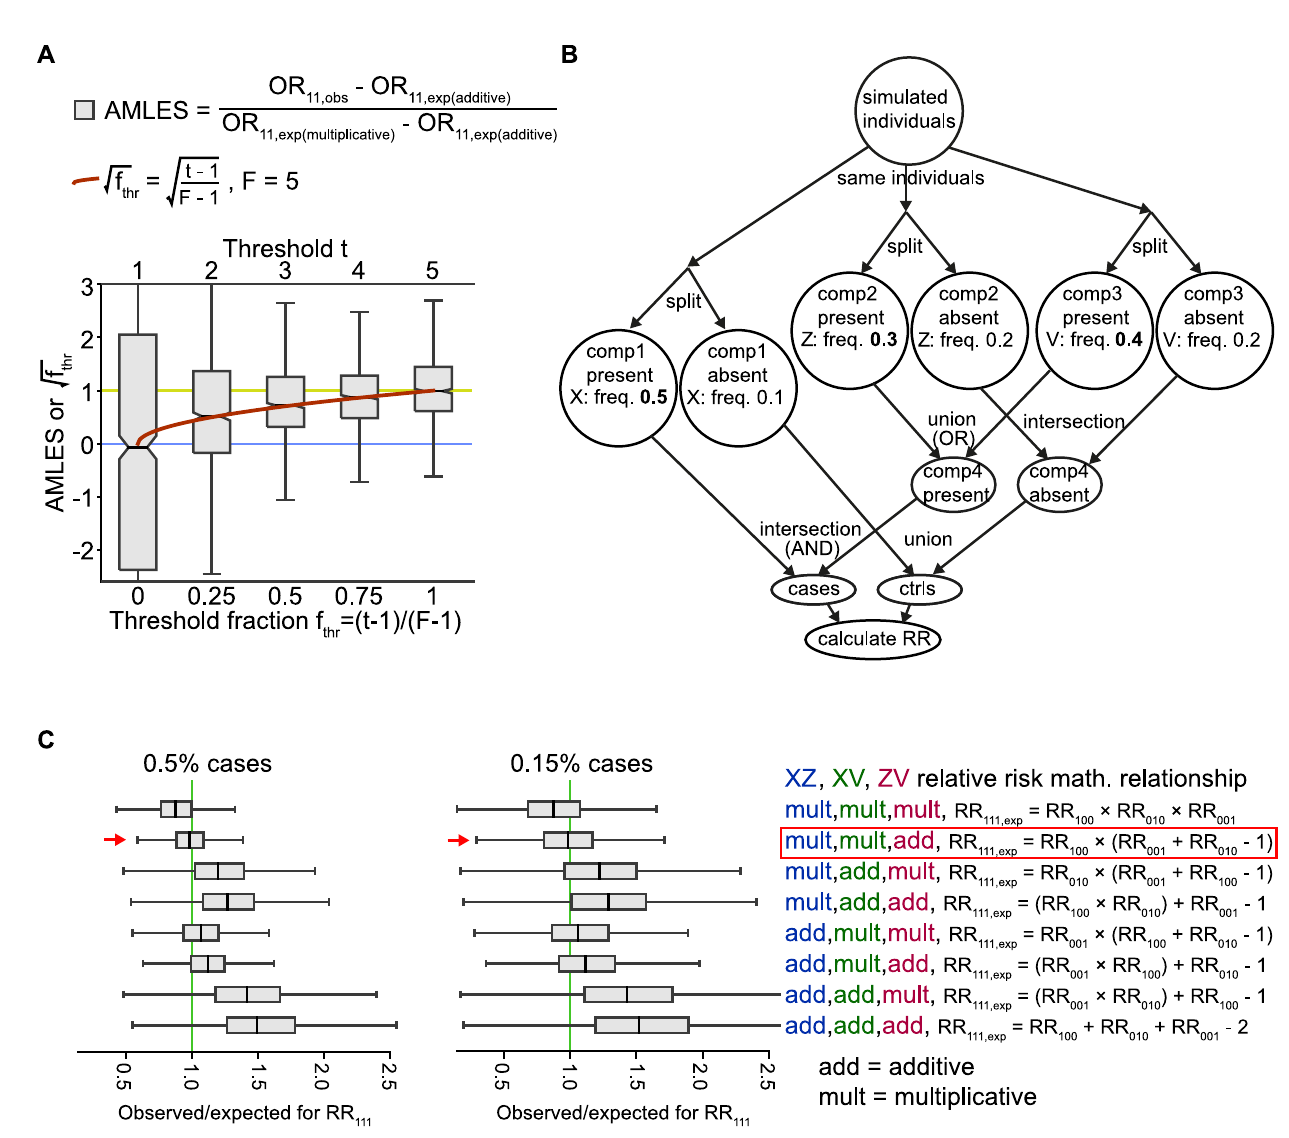
Fig 2. Relationships among risk factors in the context of the multifactorial threshold model and a 3-factor causal scenario. A : AMLES (additive-to- p multiplicative linear effect scale; grey boxes) and f est (red curve) calculated using the scenario in Fig 1C and plotted on the y axis. The notches in the box plots show bootstrapped 95% confidence intervals for the medians. The simulation had 0.5% cases and 99.5% controls, with a range ± 0.04%. B : A 3-factor simulated scenario. The numbers are example frequencies, and frequencies in bold highlight the higher frequencies representing association with disease. For example, “Z: freq. 0.3” means that each simulated individual in the group had a 30% chance of being assigned the risk factor Z. This scenario required one “component” (where X is associated with risk) together with either one of another two components (where either Z or V is associated with risk) to produce the outcome. C : Comparison of the eight possible combinations of additive (add) and multiplicative (mult) relationships from the simulation in (B). The second combination, “mult,mult,add” is highlighted by a box since the theoretical expectation was met. There are AND relations between X and Z, X and V but an OR relationship between Z and V. Therefore, RR 100 (where only X is present) is multiplied by the addition of Z and V’s relative risks, assuming that at a low trait prevalence the results from logical AND and OR follow the multiplicative and additive models,